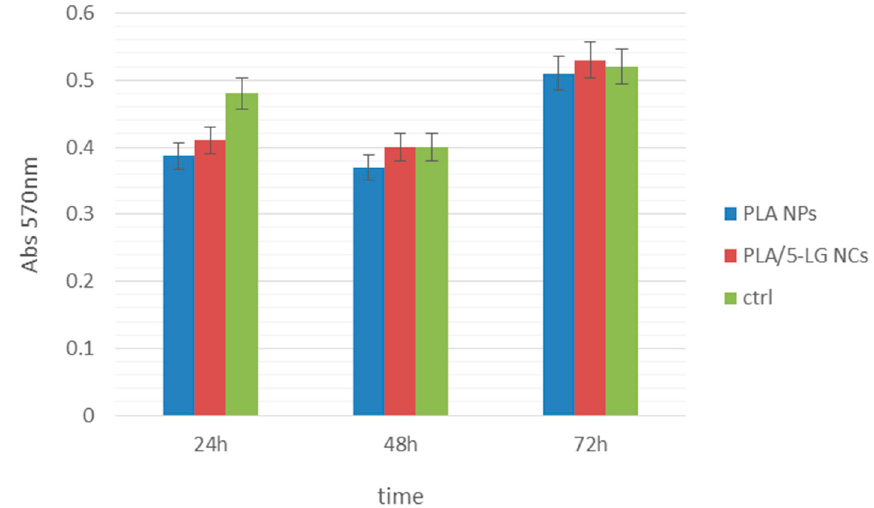
Figure 8. The viability of human amniotic fluid stem cells (AFSC) grown in the presence of PLA/5-LG NCs and in control conditions. The MTT assay shows that, after 72 h, the cells present a normal metabolism and growth capacity compared to control ( n = 3, p < 0.05%).